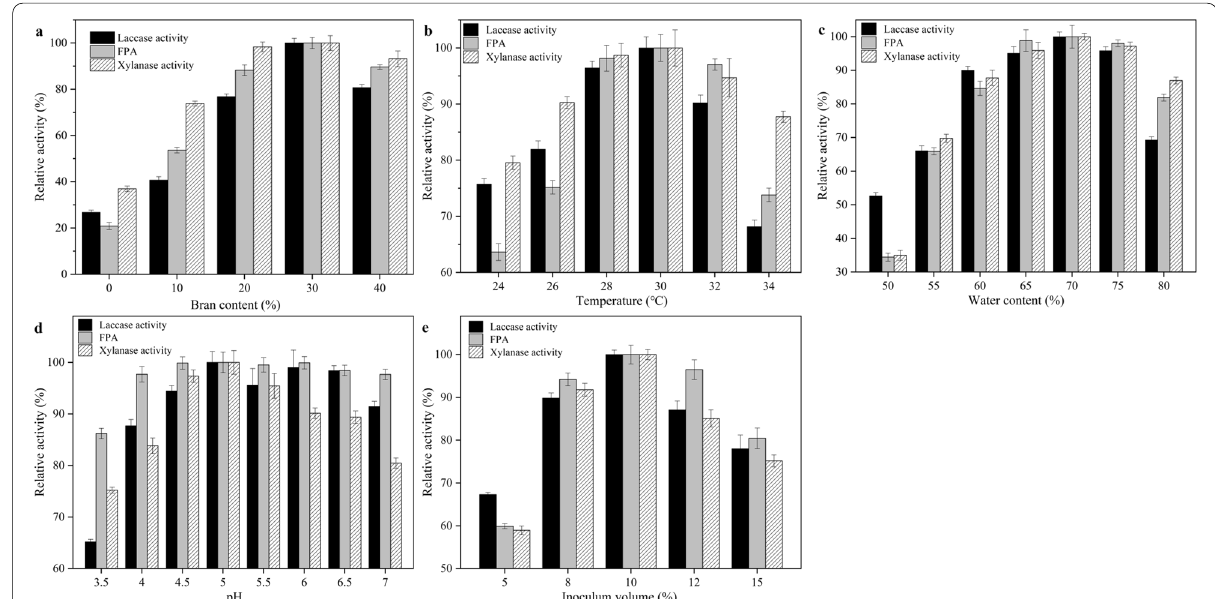
Fig. 2 Optimization of fermentation conditions, including the effect of bran content ( a ), temperature ( b ), water content ( c ), pH ( d ), and inoculum size ( e ) on enzyme production by T. reesei ZJ-09 under SSF. All samples are collected on day 10 to assay the FPA, xylanase activity, and laccase activity. Data were average values of triplicate samples and error bars indicate standard